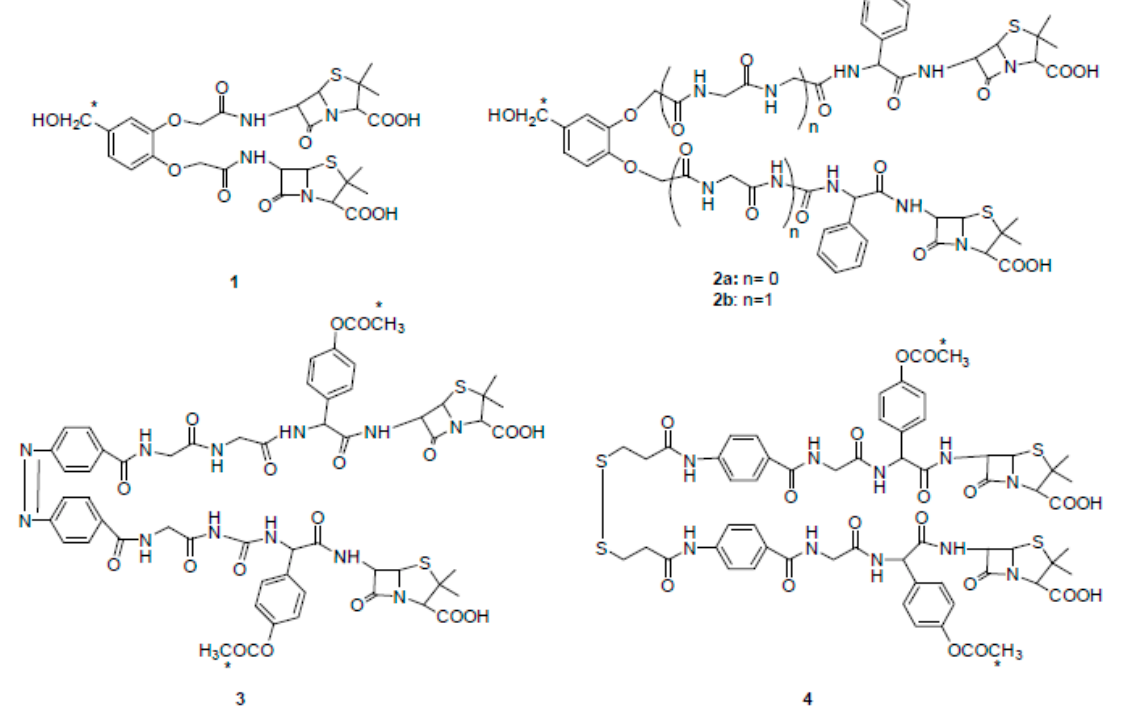
Figure 2. Chemical structures of radio-labeled bis- β -lactam compounds 1 – 4 (ref. [14]). Compound 3 is drawn in cis configuration owing to space limitations, although its configuration is trans. * indicates the radio-labeled atoms.